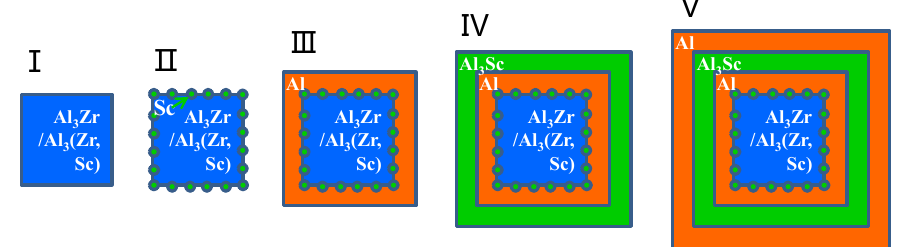
Figure 5. The schematic diagram of core-shell structure forming during solidification process with Al 3 (Zr, Sc) or as nuclei.